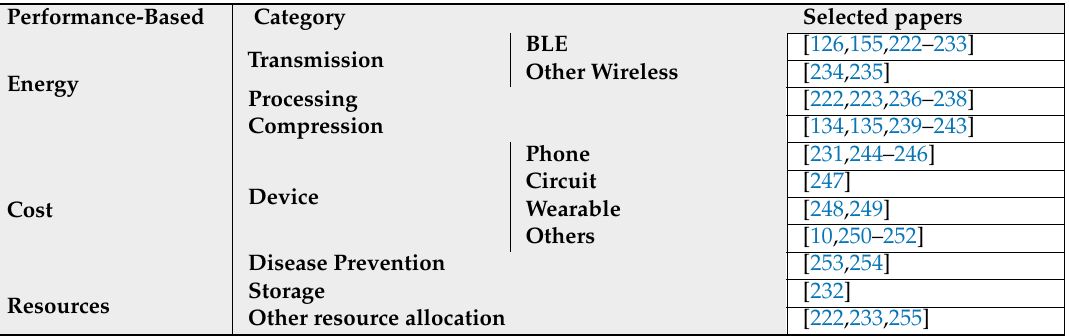
Table 6. Classification of selected performance-based ECG monitoring